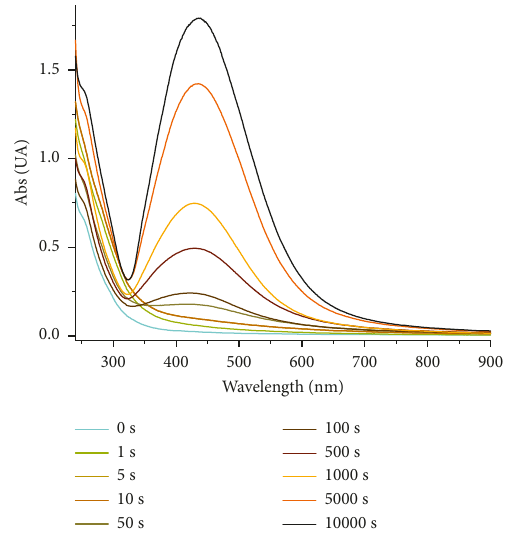
Figure 1: UV-Vis spectrum of Ag NPs synthetized with 0.5g of U. maydis at pH 10 after a long period of sunlight exposition at room temperature.